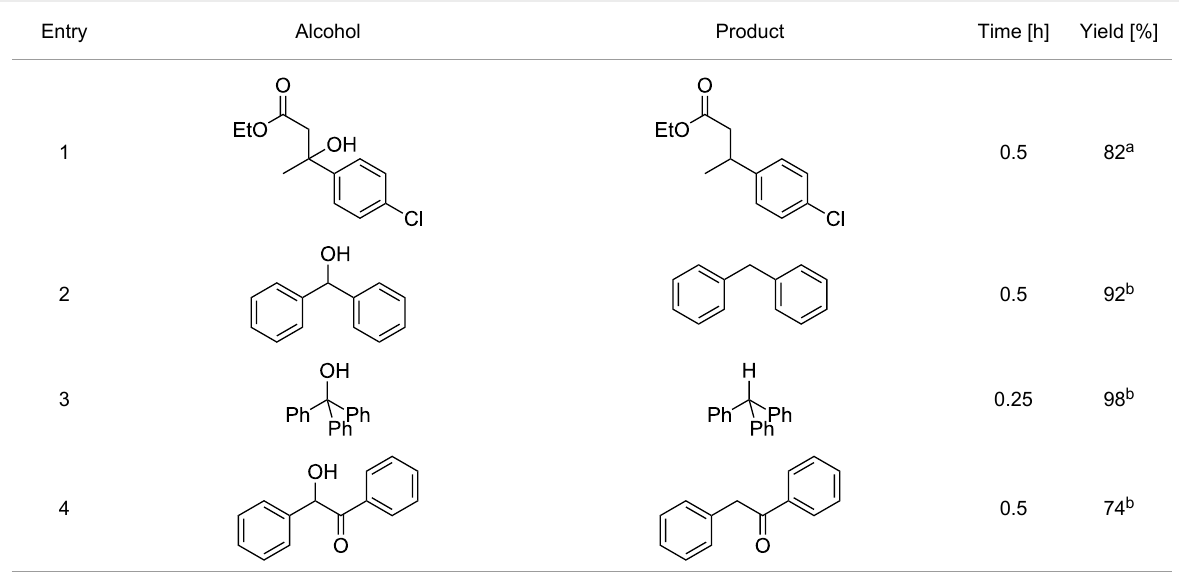
Table 4: Reduction of alcohols with catalytic amounts of hydriodic